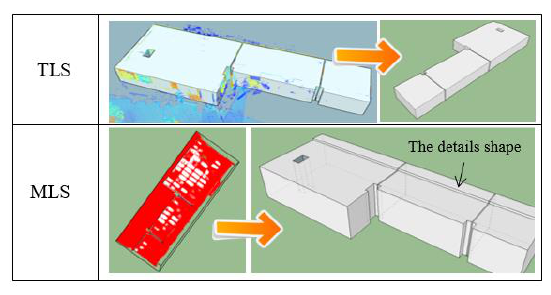
Figure 5. Point-clouds to 3D model